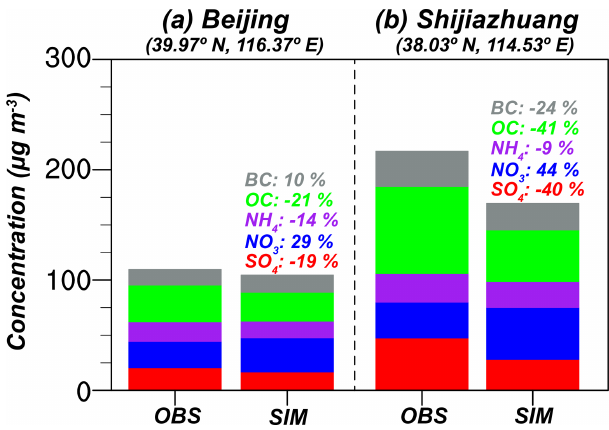
Figure 5. Comparison of observed and simulated surface-layer mass concentrations (µgm − 3 ) of SO 2 − (purple), OC (green), and BC (gray) at sites (a) in Beijing (39.97 ◦ N, 116.37 ◦ E) and (b) Shijiazhuang (38.03 ◦ N, 114.53 ◦ E) averaged over the 16–29 December 2015 period. Normalized mean biases (NMBs) are also listed for each species (colored